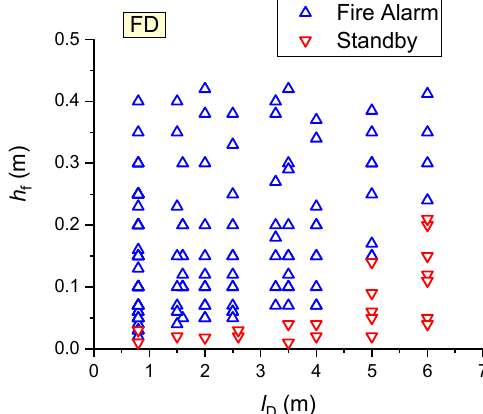
Figure 15. Summary map of FD activation/activation failure (all the results obtained during wood combustion were